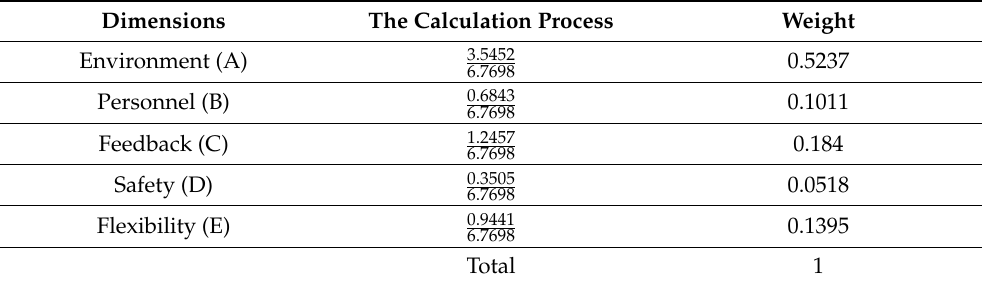
Table 6. The calculation of weight for five dimensions.